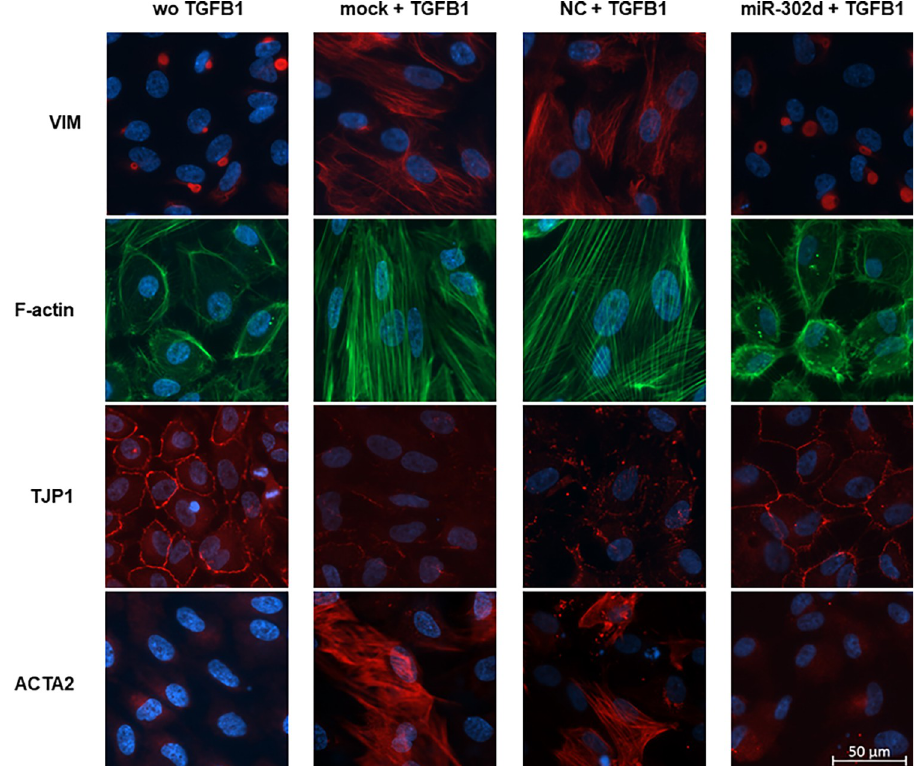
Fig 3. miR-302d inhibits TGFB-induced changes of EMT-related factors in hRPE cells. hRPE cells were treated with or without TGFB1 24 h after transfection with mock, NC, or miR-302d. Cells were immunostained for VIM, F- actin, TJP1, and ACTA2 4 d later. The scale bar represents 50 μ